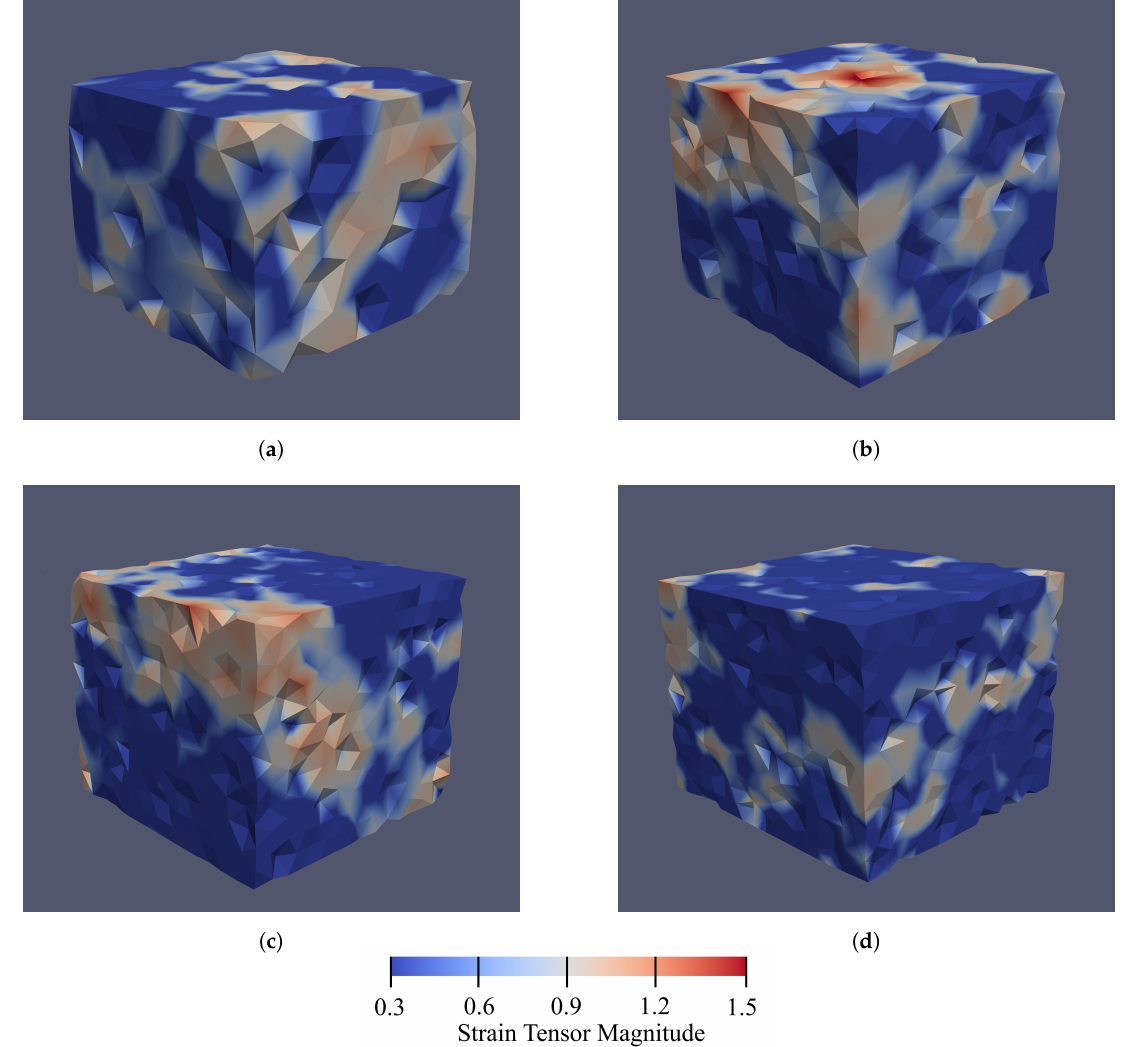
Figure 11. The magnitude of the micro-strain inside the RVEs with ( a ) 1000, ( b ) 2000, ( c ) 3000, and ( d ) 4000